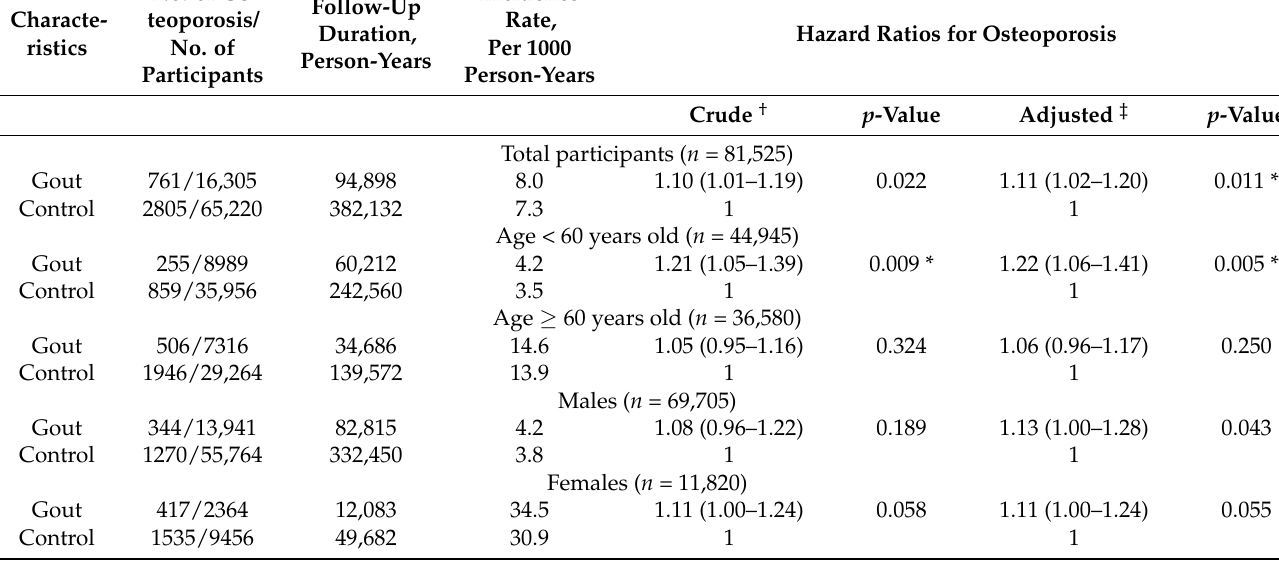
Table 2. Hazard ratio (95% confidence interval) for osteoporosis in the gout and control groups with subgroup analyses according to age and